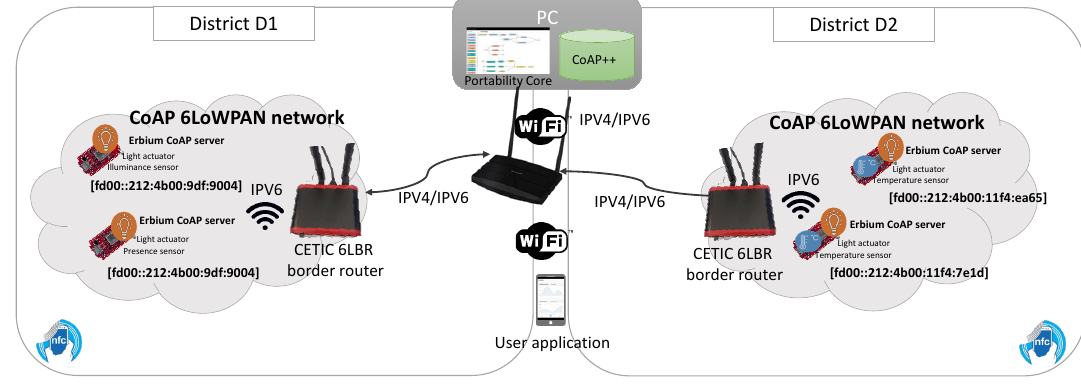
Figure 13. Smart-city use case deployment